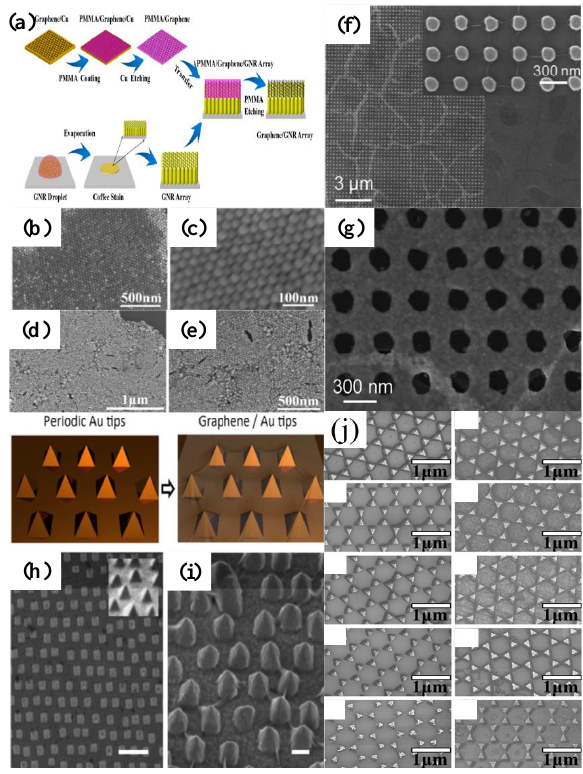
Figure 2. ( a ) The scheme of fabrication of G/GNRs-VA hybrid substrate. ( b , c ) SEM images of GNRs- VA. ( d , e ) SEM images of G/GNRs-VA. Reprinted from Ref. [71] with permission of 2019 Elsevier. ( f ) SEM images of graphene/nano-disk structures. ( g ) SEM images of graphene/nano-holes struc- tures. Reprinted from Ref. [39] with permission of 2012 American Chemical Society. ( h ) SEM images of Au nanopyramid structure. ( i ) SEM images of graphene-Au nanopyramid structure. Reprinted from Ref. [27] with permission of 2015 American Chemical Society. ( j ) the Au TNAs (left column) and G/TNAs (right column) structures, respectively. Reprinted from Ref. [73] with permission of 2017 American Chemical Society.